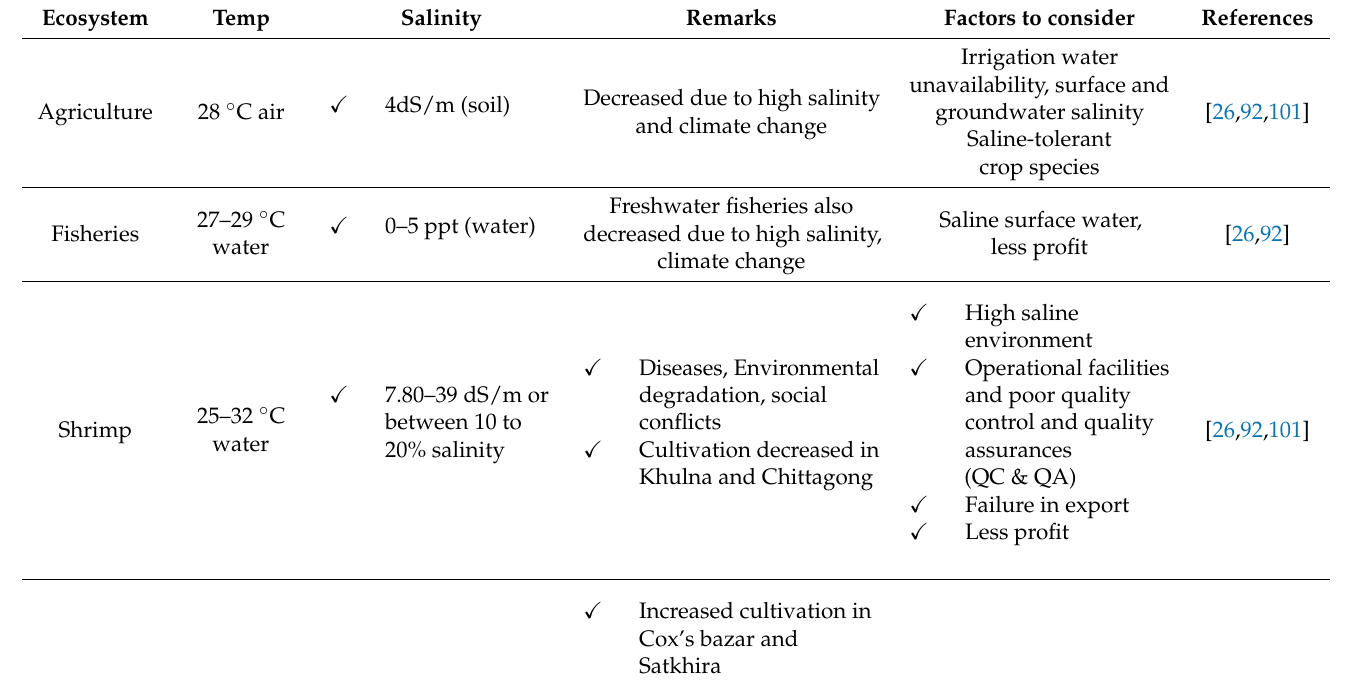
Table 2. The biophysical and hydrobiological limits of agroecological systems in the south-west region of